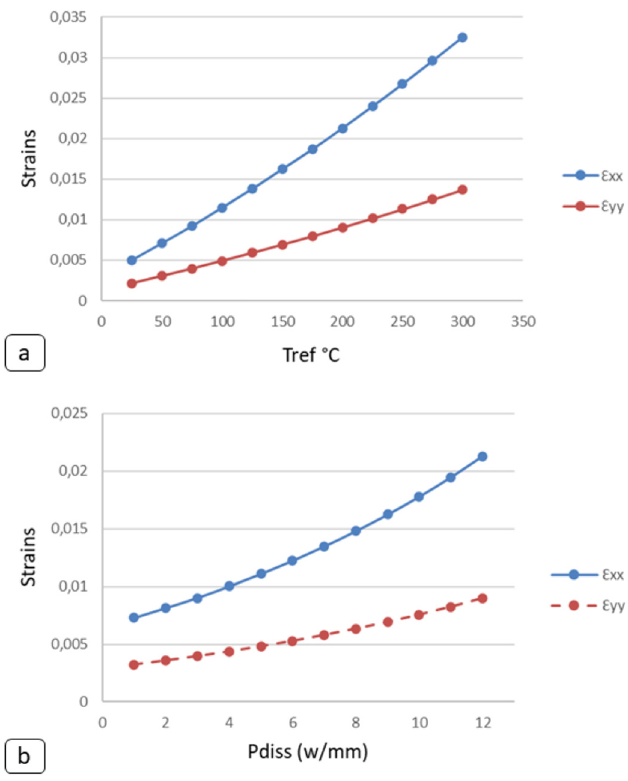
Fig. 8. Evolution of the maximum principal strains in the HEMT structure as a function of the power dissipated (a), and as a function of the reference temperature